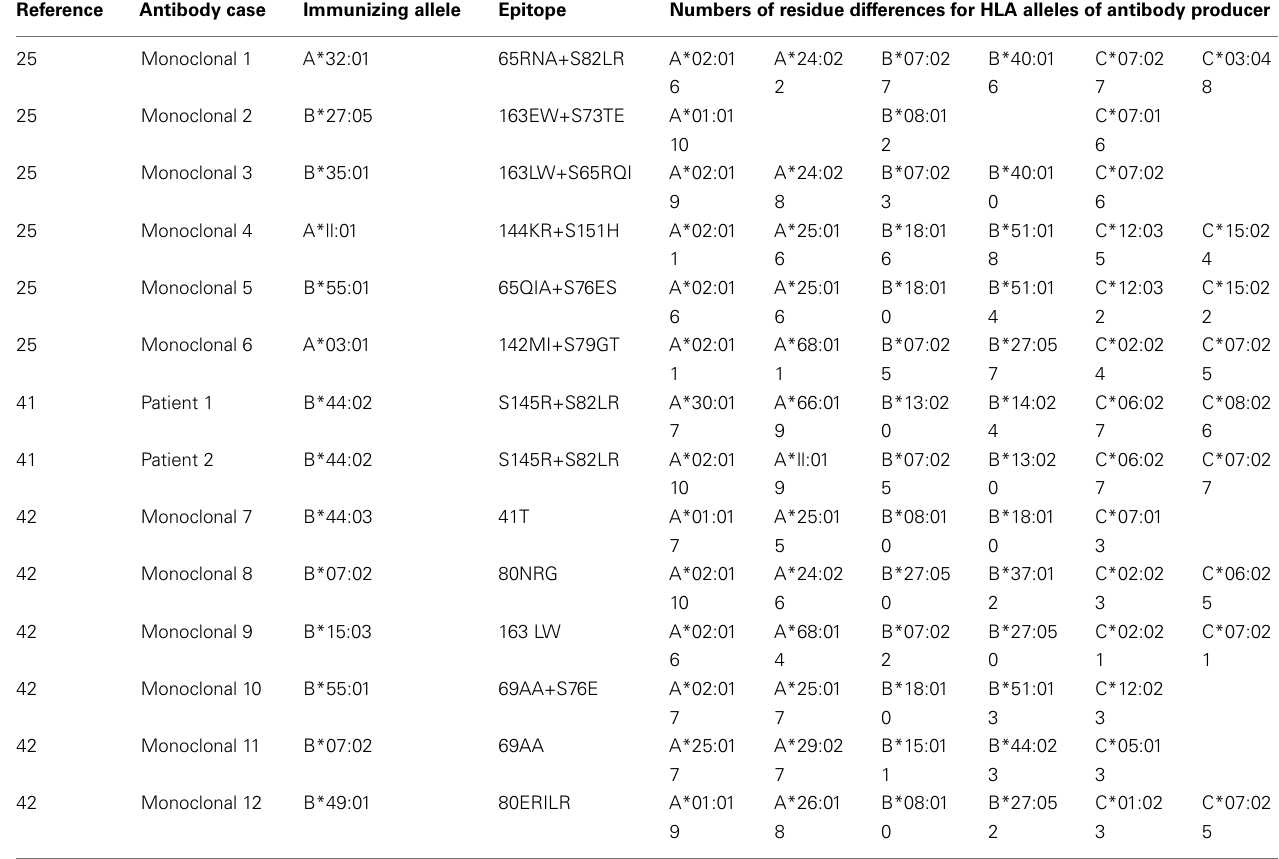
Table 3 | Examples of polymorphic residue differences within 15Å of mismatched eplets on antibody-defined epitopes on immunizing alleles and the alleles of the antibody